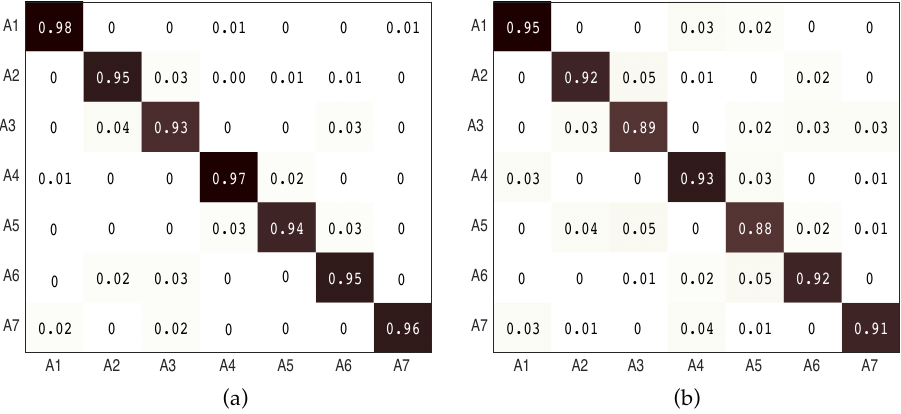
Figure 5. The confusion matrices in both LOS and NLOS scenarios. ( a ) The confusion matrix in an LOS scenario; ( b ) the confusion matrix in an NLOS scenario.